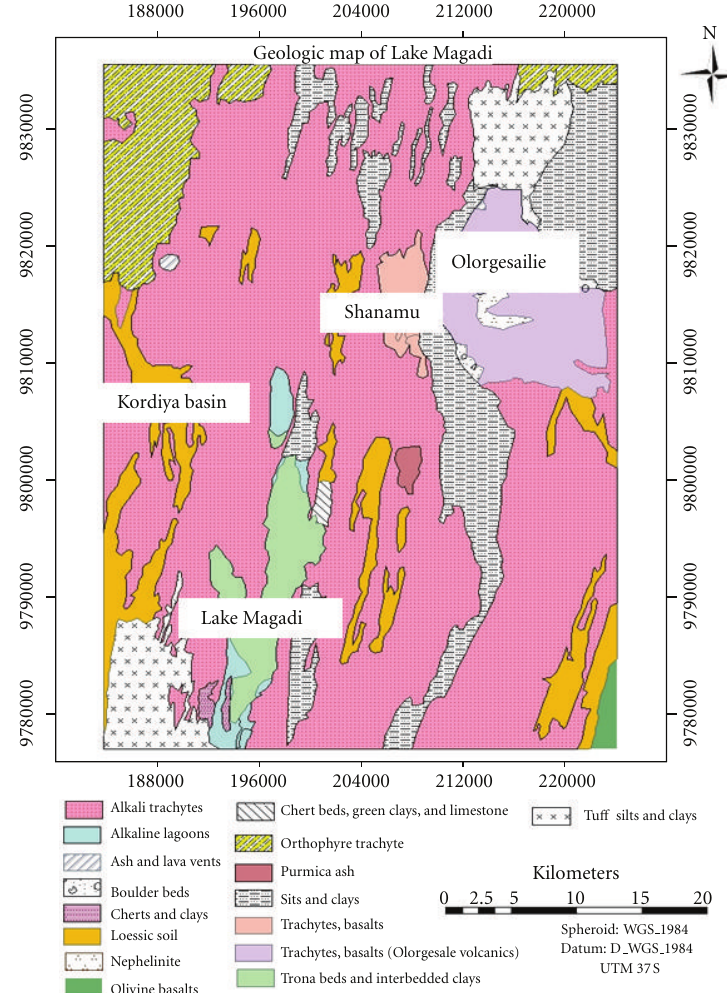
Figure 3: Geological map of Lake Magadi area after